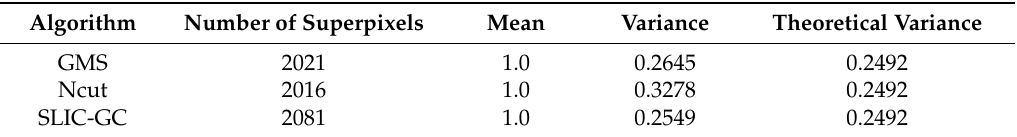
Table 1. Means and variances of the ratio images for the different superpixel segmentation algorithms with the AirSAR image.